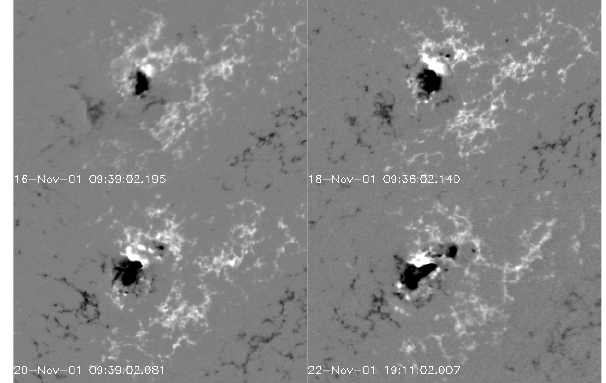
figuration of AR 9704. The images have been derotated to central meridian passages (CMP). The FOV is 319 × 207 pixels (each pixel is 1.98 arcsec size) and the field is saturated below (above) − 500G